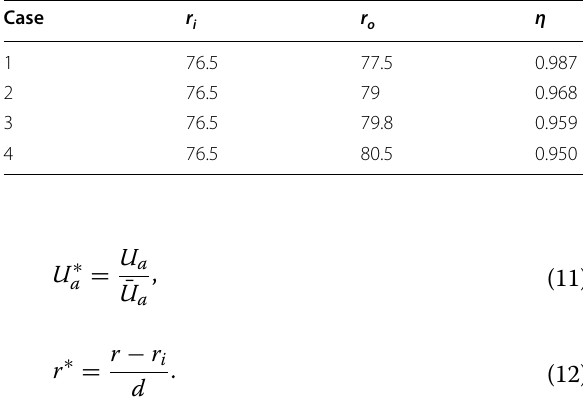
three regions: two boundary layers and a central region, and the simulated data were in good agreement with the measurements in the central region. The test was invalid in the boundary layers due to device constraints such as the wall curvature.